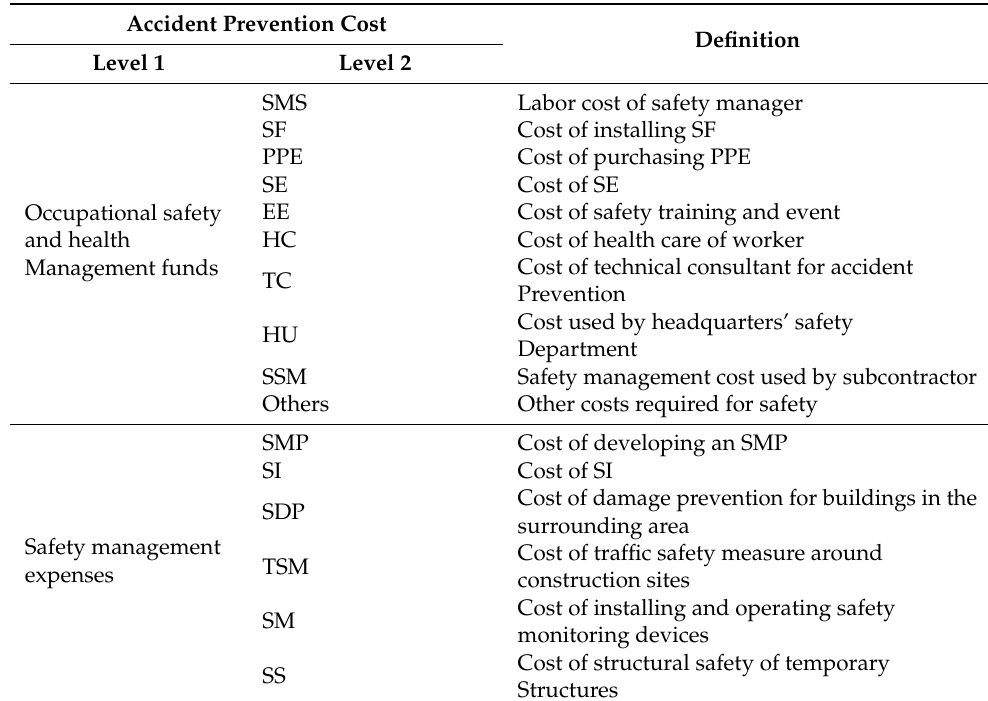
Table 5. Construction APC structure in South